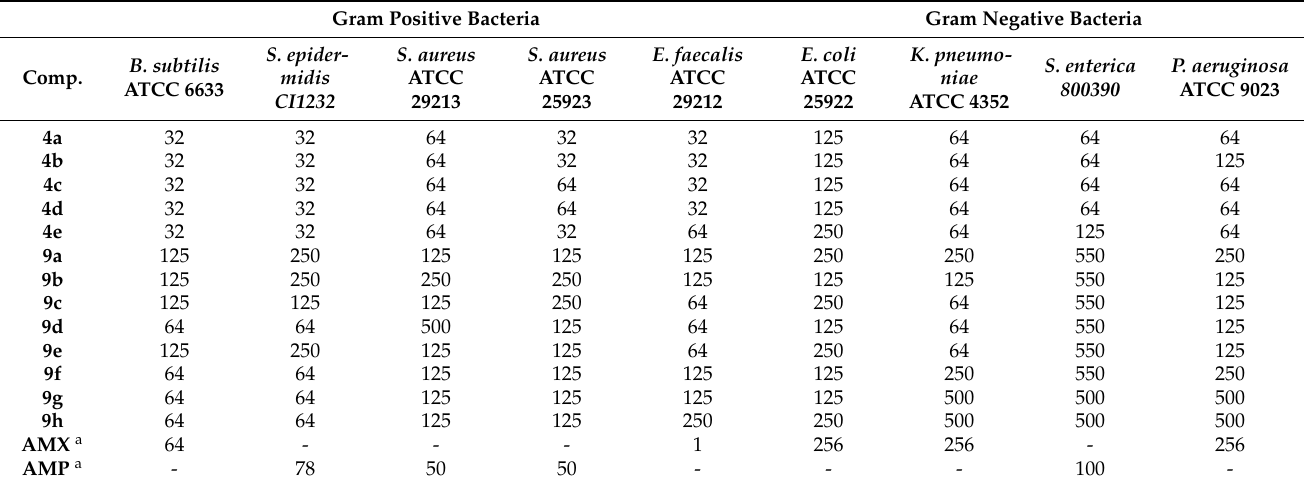
Table 4. MIC values (in µ g/mL) of the target compounds 4 and 9 against Gram-positive and Gram- negative bacteria activities.